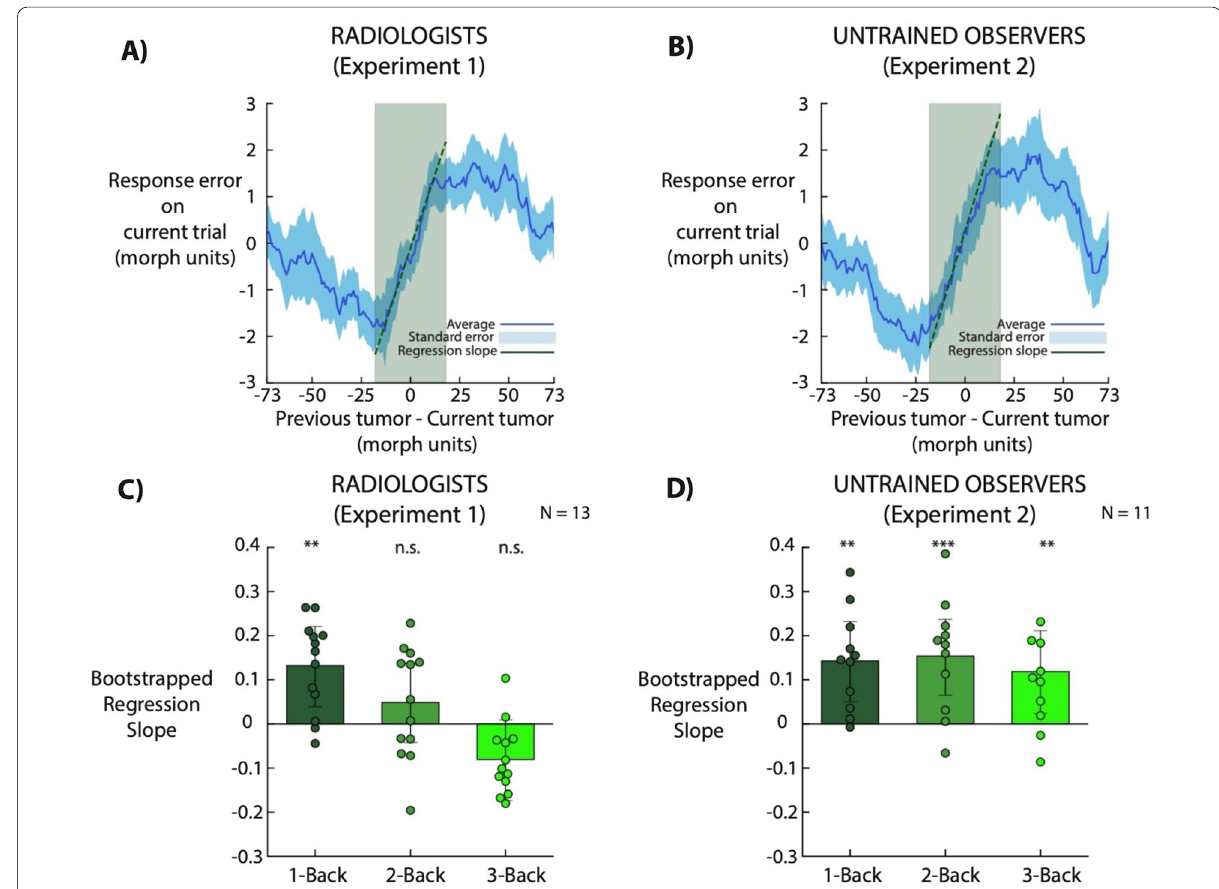
Fig. 4 Serial dependence effect size estimation. A , B Blue lines indicate the average of the running averages across observers (same data as Fig. 2). Light‑blue shaded error bars indicate standard error across observers. We fitted a linear regression on the response error as a function of the relative morph difference from 17 to 17 morph units (model fit depicted as green dashed line; fit on average of running averages). Dark green shaded − + areas indicate the morph relative difference considered in the regression analysis. C , D Bootstrapped regression slopes for 1, 2, and 3 trials back. Each filled dot represents the regression slope for a single observer. Bars indicate the group bootstrap slope and error bars are bootstrapped 95% confidence